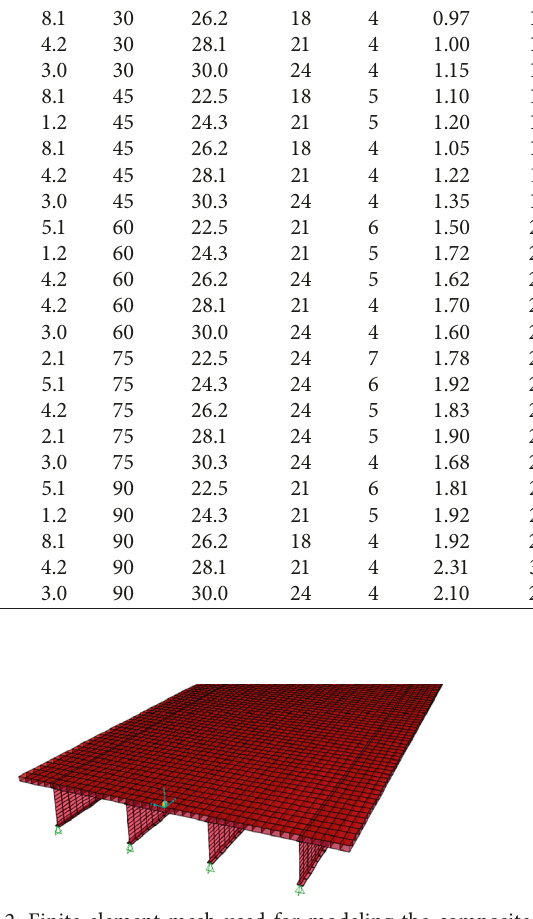
Figure 2: Finite element mesh used for modeling the composite slab-on-girder bridges with simple supported